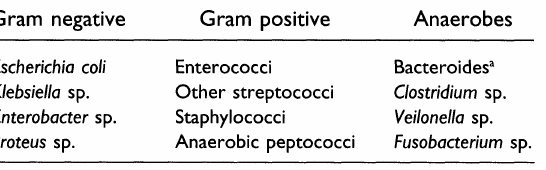
TABLE 4. Antibiotic regimens for the treatment of puerperal